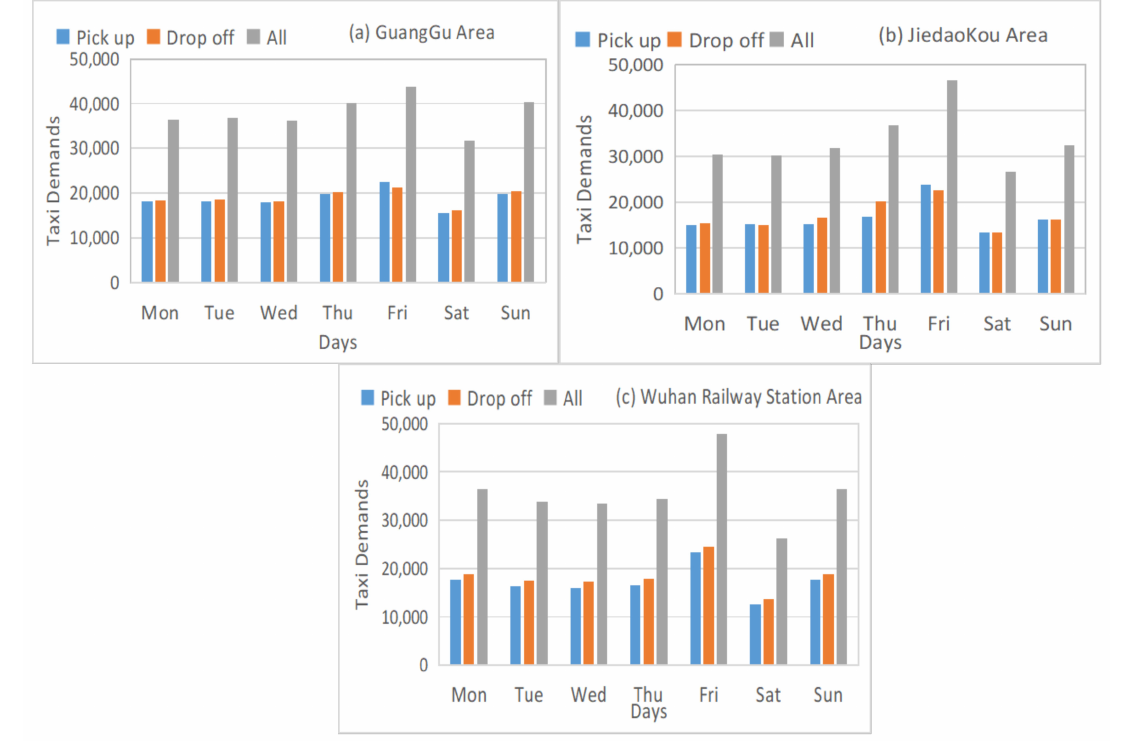
Figure 6. Taxi demands distribution in Weekdays and Weekends in the city of Wuhan. Weekday show high taxi demands as they related to working time, Sunday has a high number of Taxi demands as well.